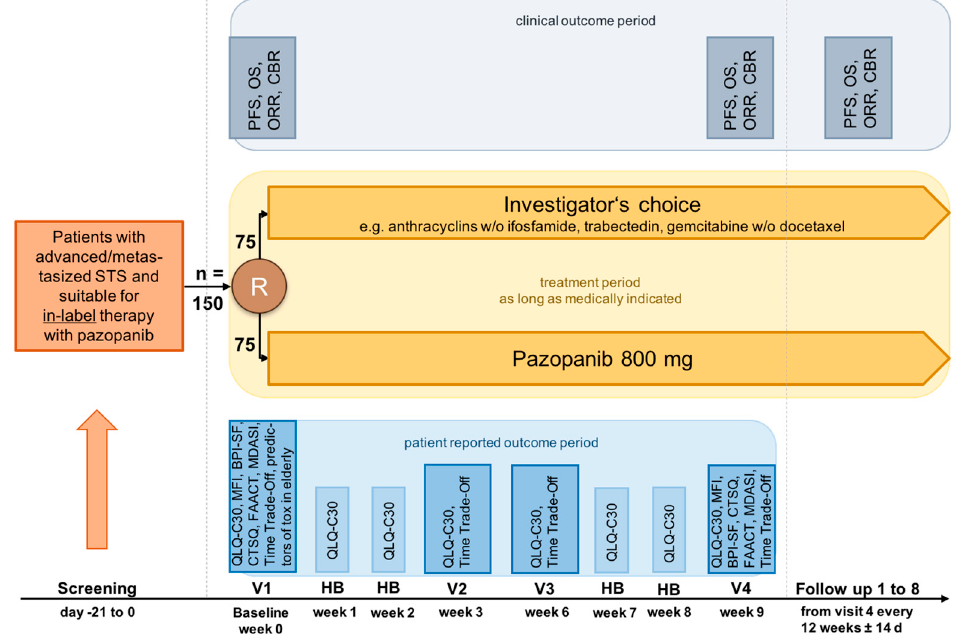
Figure 1. PazoQoL study design. STS, soft tissue sarcoma; V1–4, visit 1–4; HB, home based patient reported outcome measures; PFS, progression free survival; OS, overall survival; ORR, objective remission rate; CBR, clinical benefit rate; QLQ C30, EORTC QoL questionnaire; BPI-SF, brief pain inventory; CTSQ, Cancer therapy satisfaction questionnaire; FAACT, functional assessment of anorexia/cachexia therapy; MDASI, M.D. Anderson symptom inventory; MFI, multidimensional fatigue inventory.